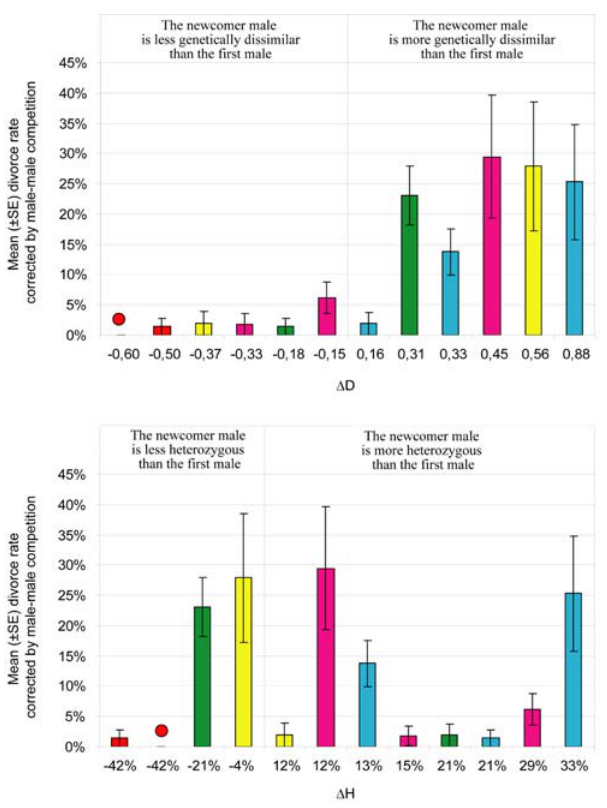
Figure 3. Influence of genetic dissimilarity between mates and male heterozygosity on divorce rate corrected by male-male competition in schistosomes. Genetic dissimilarity was estimated using the r coefficient of Wang [20] and heterozygosity was calculated for each male clone as the number of heterozygous loci divided by the total number of loci. We defined D H as the difference in overall heterozygosity between the newcomer male and the first male, and D D as the difference in genetic dissimilarity to the female between the first male and the newcomer male (Table 1). When positive, D H and D D indicate increased heterozygosity in females’ progeny. Each colour represents a different female clone. The intensity of male-male competition is measured as the number of individuals introduced during the second infection divided by the number of individual of the same sex introduced on the first one. A total of 528 pairs was